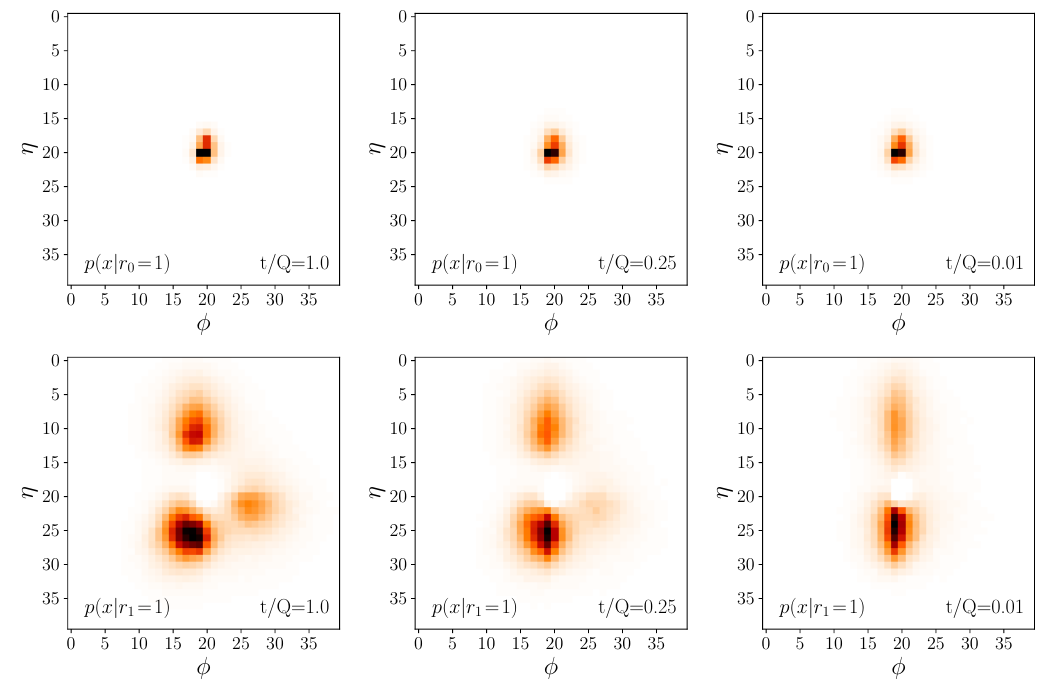
Figure 10: Learned mixture distributions extracted from the decoder weights with various amounts of anomalous top jets in the